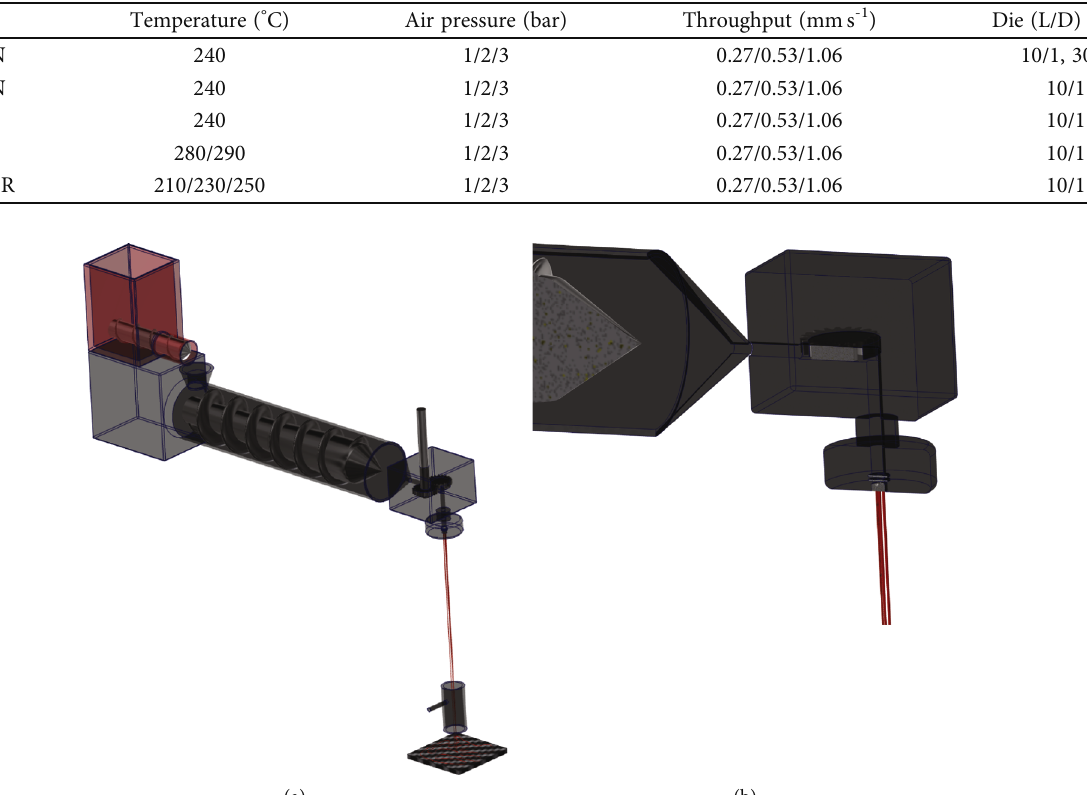
Figure 2: Schematic fi gure of pilot melt spinning device with aspirator and fi bre laydown (a) and half-view of expansion into melt pump and spinneret with two fi lter platelets, die featuring three holes, and exiting fi bres (b).